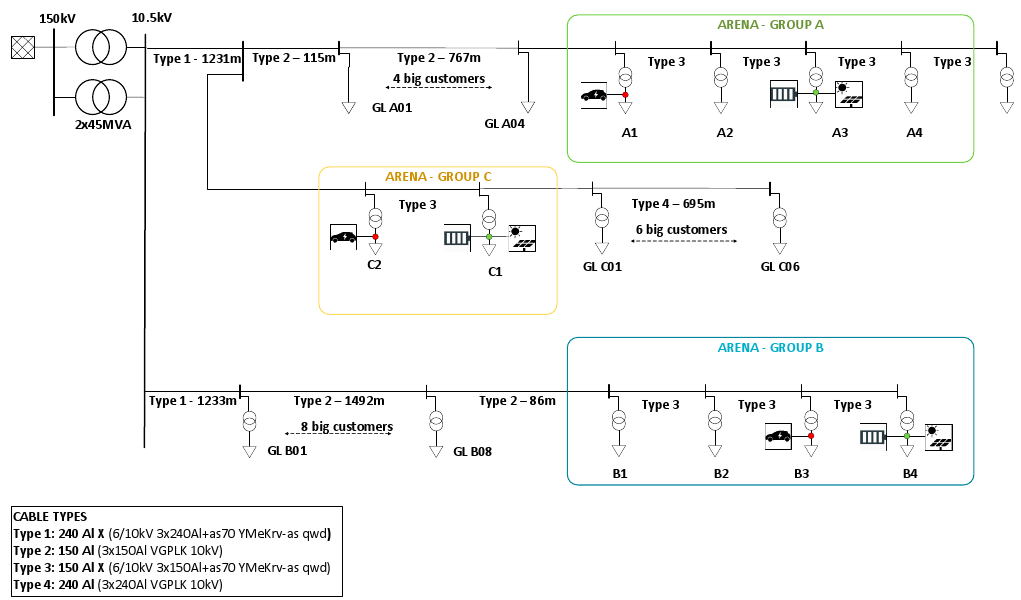
Figure 2. Single line diagram of the network supplying the ArenA. This is the network topology that is used during normal operation, with 3 groups of transformers (A–C) supplying the ArenA.